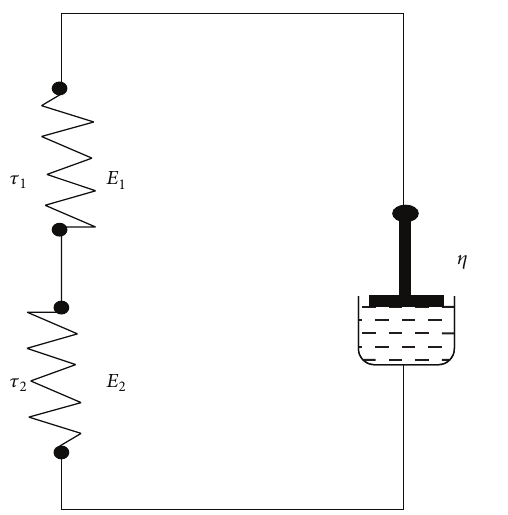
Figure 6: Effective mechanical scheme of a liquid surface coated with colloidal particles ( 𝐸 1 , 𝐸 2 are the effective Young moduli; 𝜂 is the viscosity of the